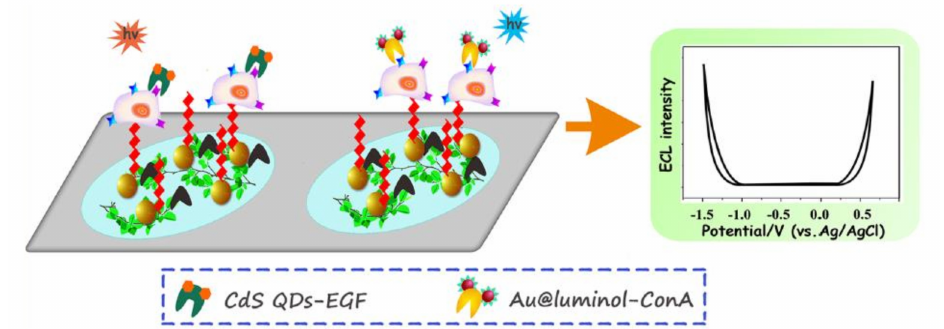
Figure 7. Schematic illustration of the dual ECL signal system. ECL signals at cathodic and anodic potentials can be obtained using CdS quantum dots (QDs) and luminol as ECL emitters, respectively. Reproduced with permission from